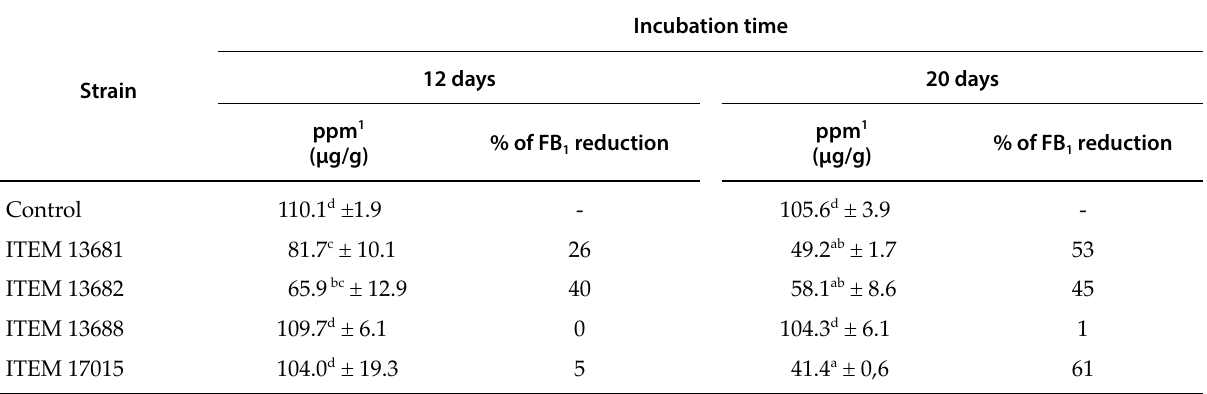
Table 2. FB 1 reduction of different P. eryngii strains on contaminated maize substrate (MCONT) compared to the control (uninoculated